Question: Describe this figure in one sentence.
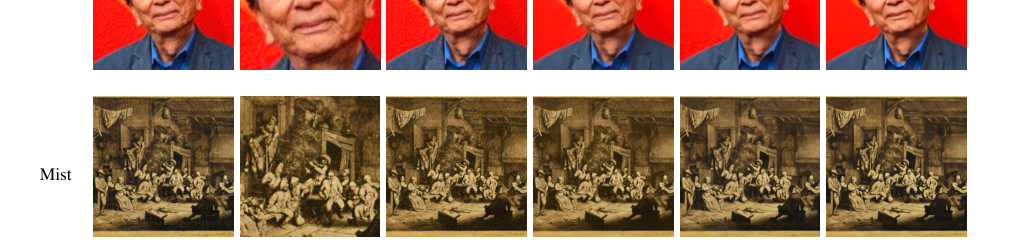
Answer: PDM-Pure Compared With Other Baseline Methods: we test all the baselines on three typical kinds of protection methods, with δ = 16/255. PDM-Pure shows strong performance.